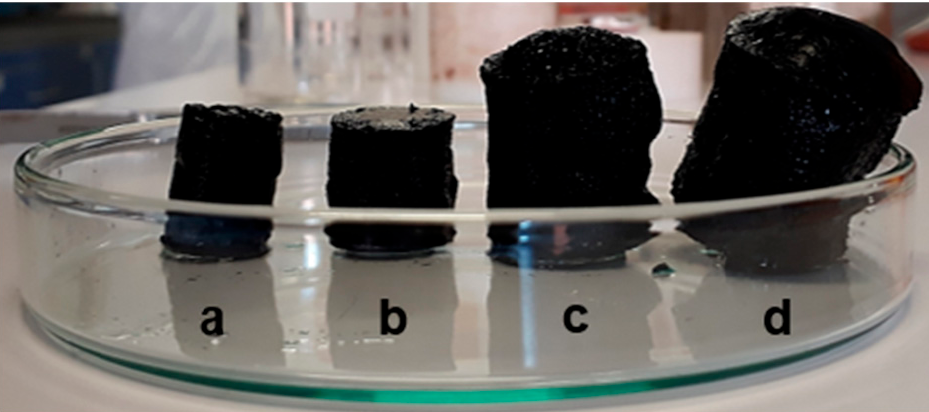
Figure 1. Optical image of the reduced graphene oxide (rGO) samples: ( a ) graphene oxide (GO):caffeic acid (CA) (1:0), ( b ) GO:CA (1:0.1), ( c ) GO:CA (1:0.5), and ( d ) GO:CA (1:1).